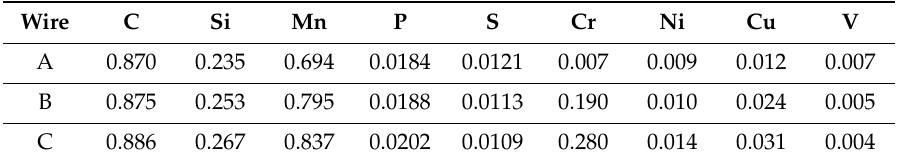
Table 1. Chemical composition of steel wires (mass fraction) /